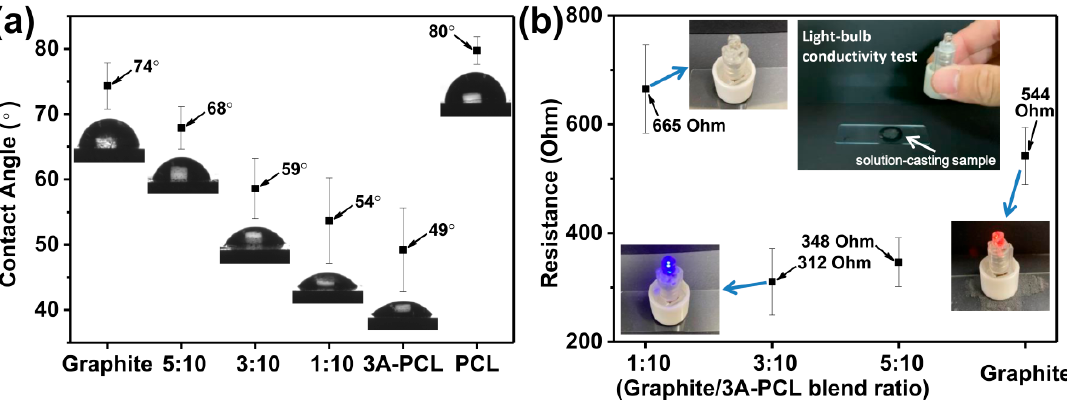
Figure 2. ( a ) WCA analysis of pristine graphite, graphite/3A-PCL composites, 3A-PCL and commercial PCL; ( b ) electrical resistance values for the graphite and graphite/3A-PCL composites. The photographs in the inset of ( b ) present the conductivity performance of graphite and graphite/3A-PCL composites through a simple light bulb conductivity apparatus.